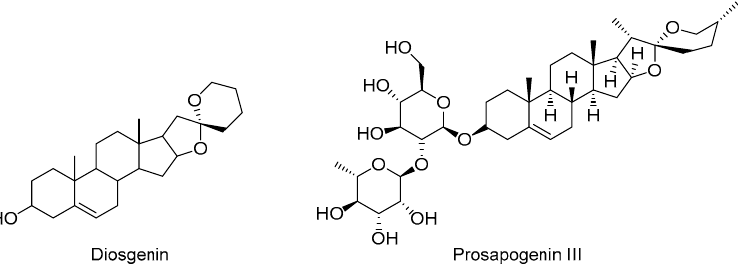
Figure 6. Chemical structure of natural steroids with anti-inflammatory activity.